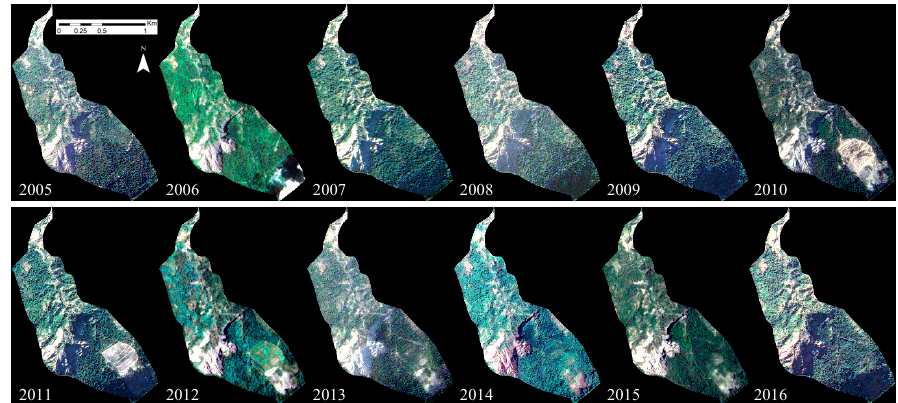
Figure 5. An example of shadow compensation in the watershed of a potential debris flow torrent Tainan DF045. The landslide area ratio time series calculated before and after the shadow compensation are denoted as blue and red lines, respectively.